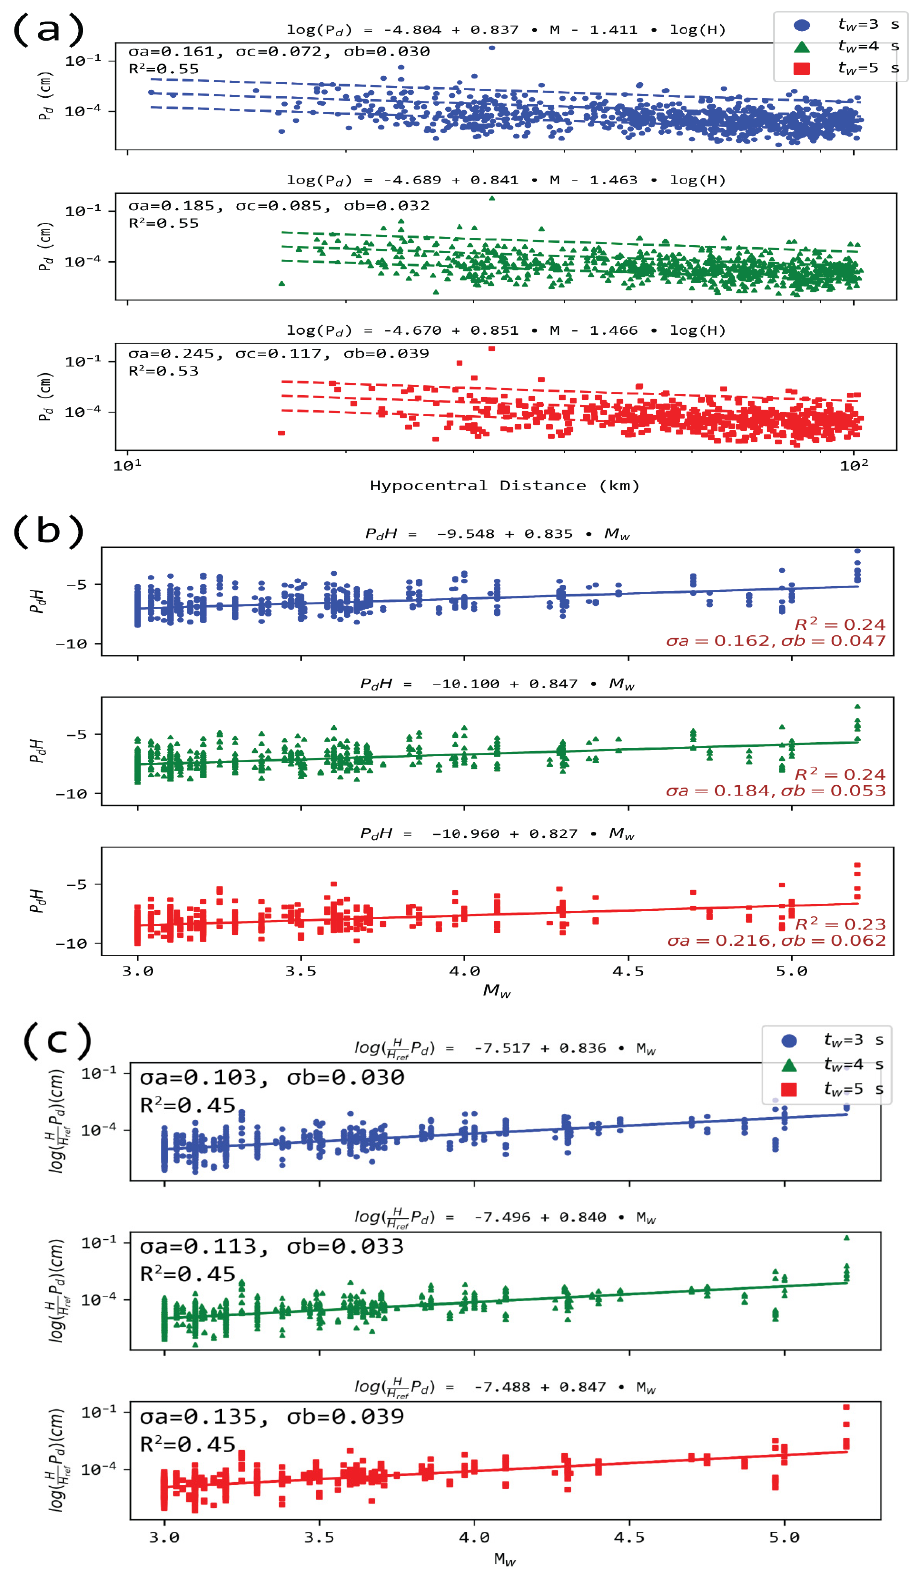
Figure 5. Regression analysis for ( a ) P d for the overall dataset and ( b ) P d H = log ( P d ) − c ∗ log ( H ) , using c for each t w as seen in panel ( a , c ) for the corrected P d for the overall dataset by a factor determined by the hypocentral distance and a reference distance H ref = 100 km. The σ b refers to the coefficient of the magnitude variable. The rest of the notation as in Figure 3.